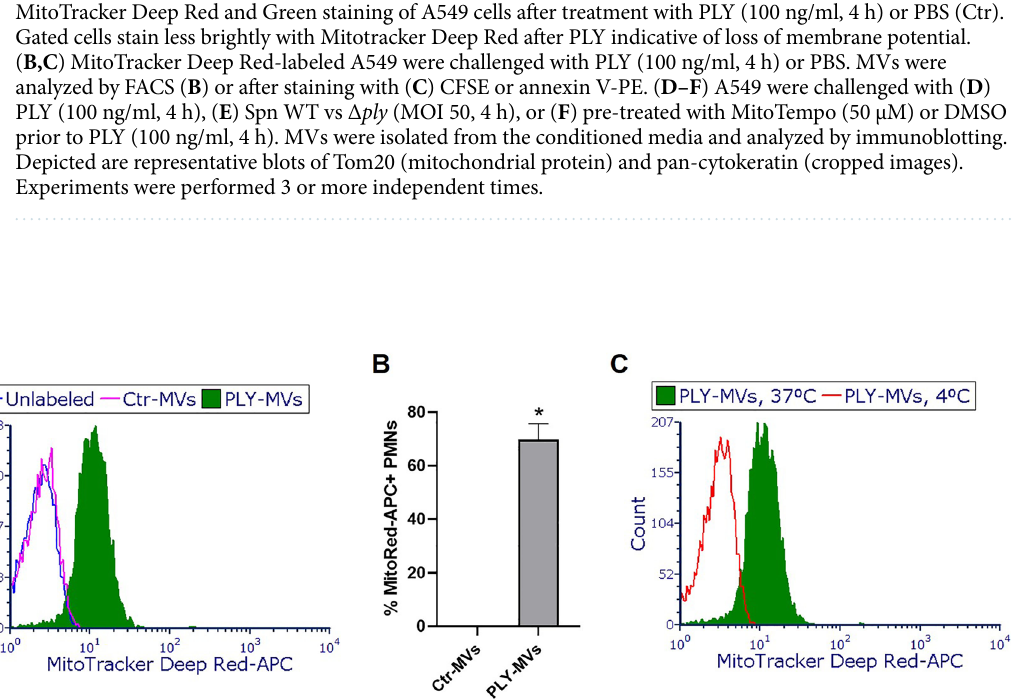
Figure 7. Microvesicles (MVs) released from pneumolysin (PLY)-treated lung alveolar epithelial cells are taken up by neutrophils. Human neutrophils (PMNs) were incubated with Ctr- or PLY-MitoTracker Deep Red- MVs [MVs were isolated from MitoTracker Deep Red-labeled A549 cells after treatment with PLY (100 ng/ml) or PBS- control (Ctr) at 37 °C or 4 °C for 1 h. PMNs were then analyzed by FACS for MitoTracker Deep Red signal. ( A ) Representative histogram of live PMNs (CD11b positive/7-AAD negative) treated with unlabeled MVs, Ctr- or PLY- MVs, at 37 °C. ( B ) Quantification of the percentage of MitoTracker Deep Red positive PMNs, n = 4, *p < 0.0001 (Mann–Whitney test, unpaired). ( C ) Representative histogram of live PMNs (CD11b positive/7- AAD negative) treated with PLY-MVs at 37 °C or 4